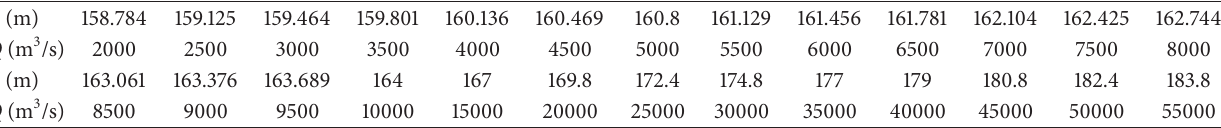
Table 1: The water level-discharge line in Chongqing Cuntan station (Yellow Sea Elevation).